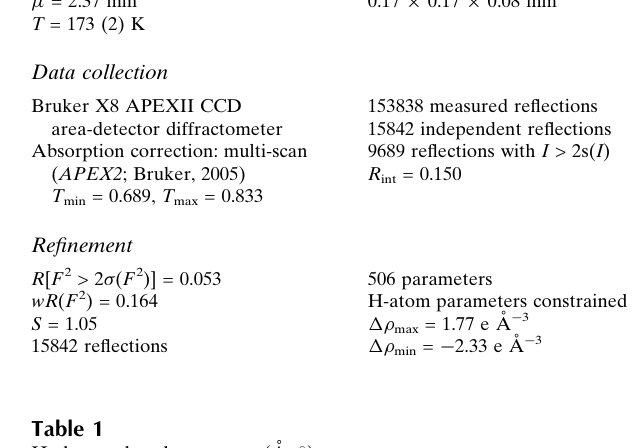
Hydrogen-bond geometry (A˚ , (cid:3)